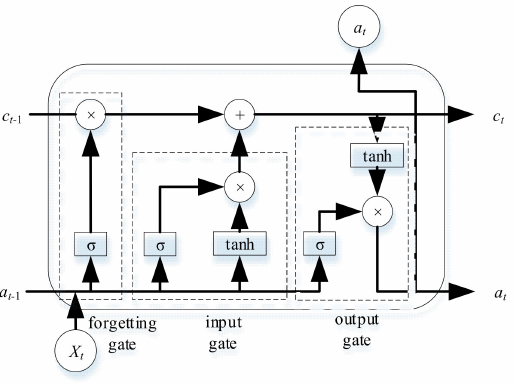
Figure 1. Internal structure diagram of long and short-term memory (LSTM) neural